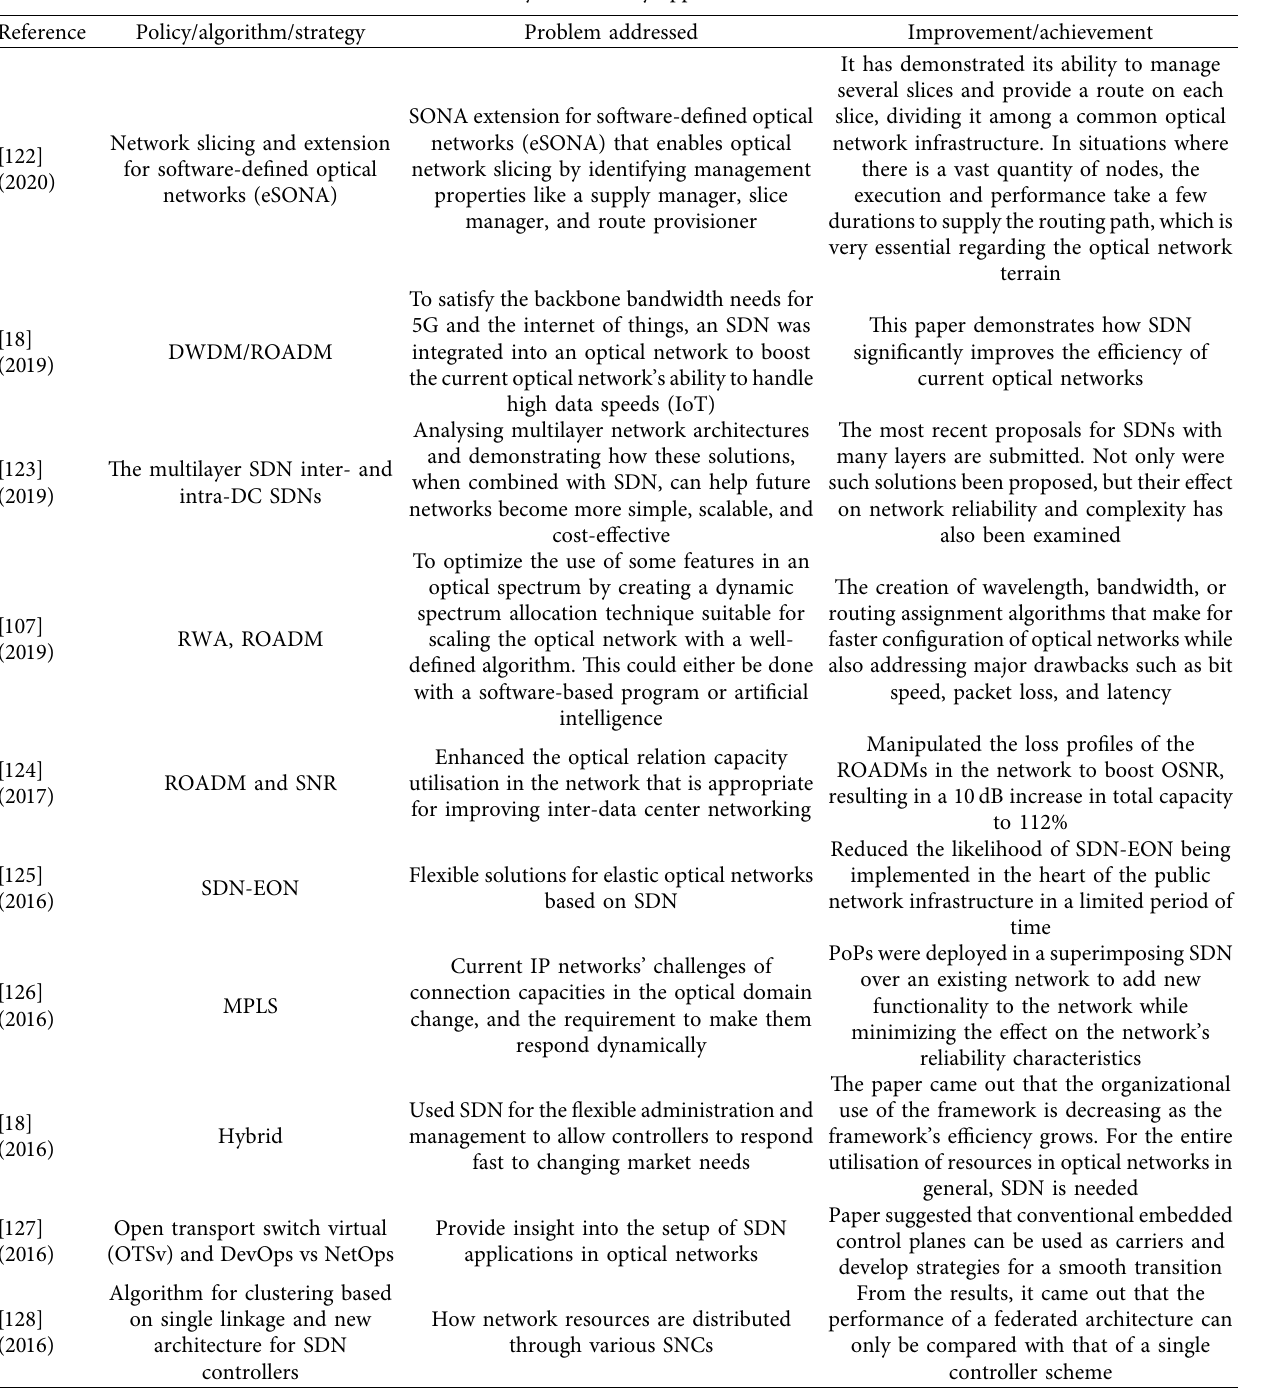
Table 9: Summary of flexibility approaches for